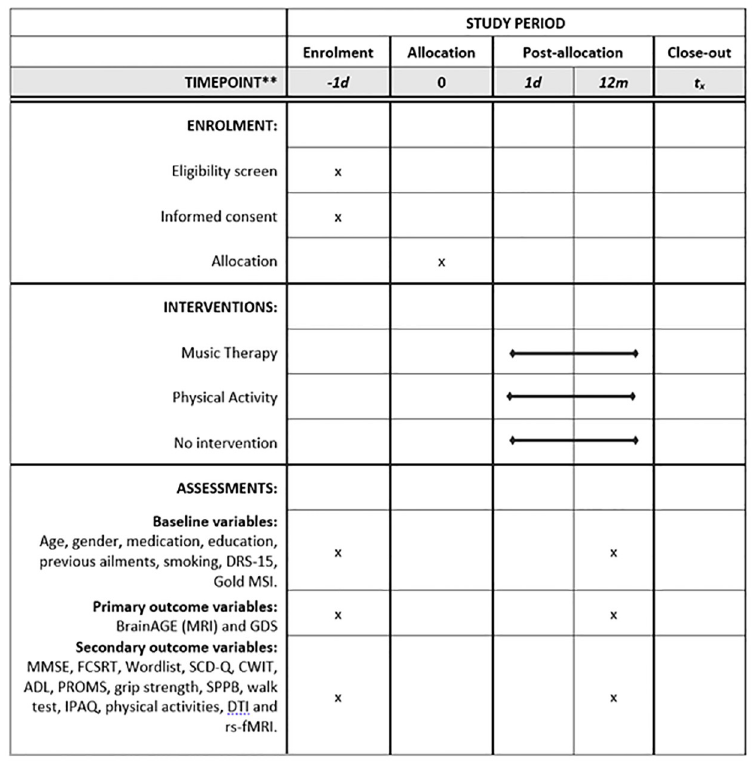
Fig 1. The schedule of enrolment, interventions, and assessments. Abbreviations: DRS-15 –Dispositional Resilience Scale 15; GOLD MSI—Goldsmiths Musical Sophistication Index; BrainAGE—Brain Age Gap Estimation; MRI— Magnetic Resonance Imaging; GDS—Geriatric Depression Scale; MMSE—Mini Mental Status Examination; FCSRT— Free and Cued Selective Reminding Test; SCD-Q—Subjective Cognitive Decline-Questionnaire; CWIT—Colour Word Interference Test; ADL—Activities of Daily Living; PROMS—Profile of Music Perception Skills; SPPB—Short Physical Performance Battery; IPAQ—International Physical Activity Questionnaire; DTI—Diffusion Tensor Imaging; rs-fMRI—resting state functional